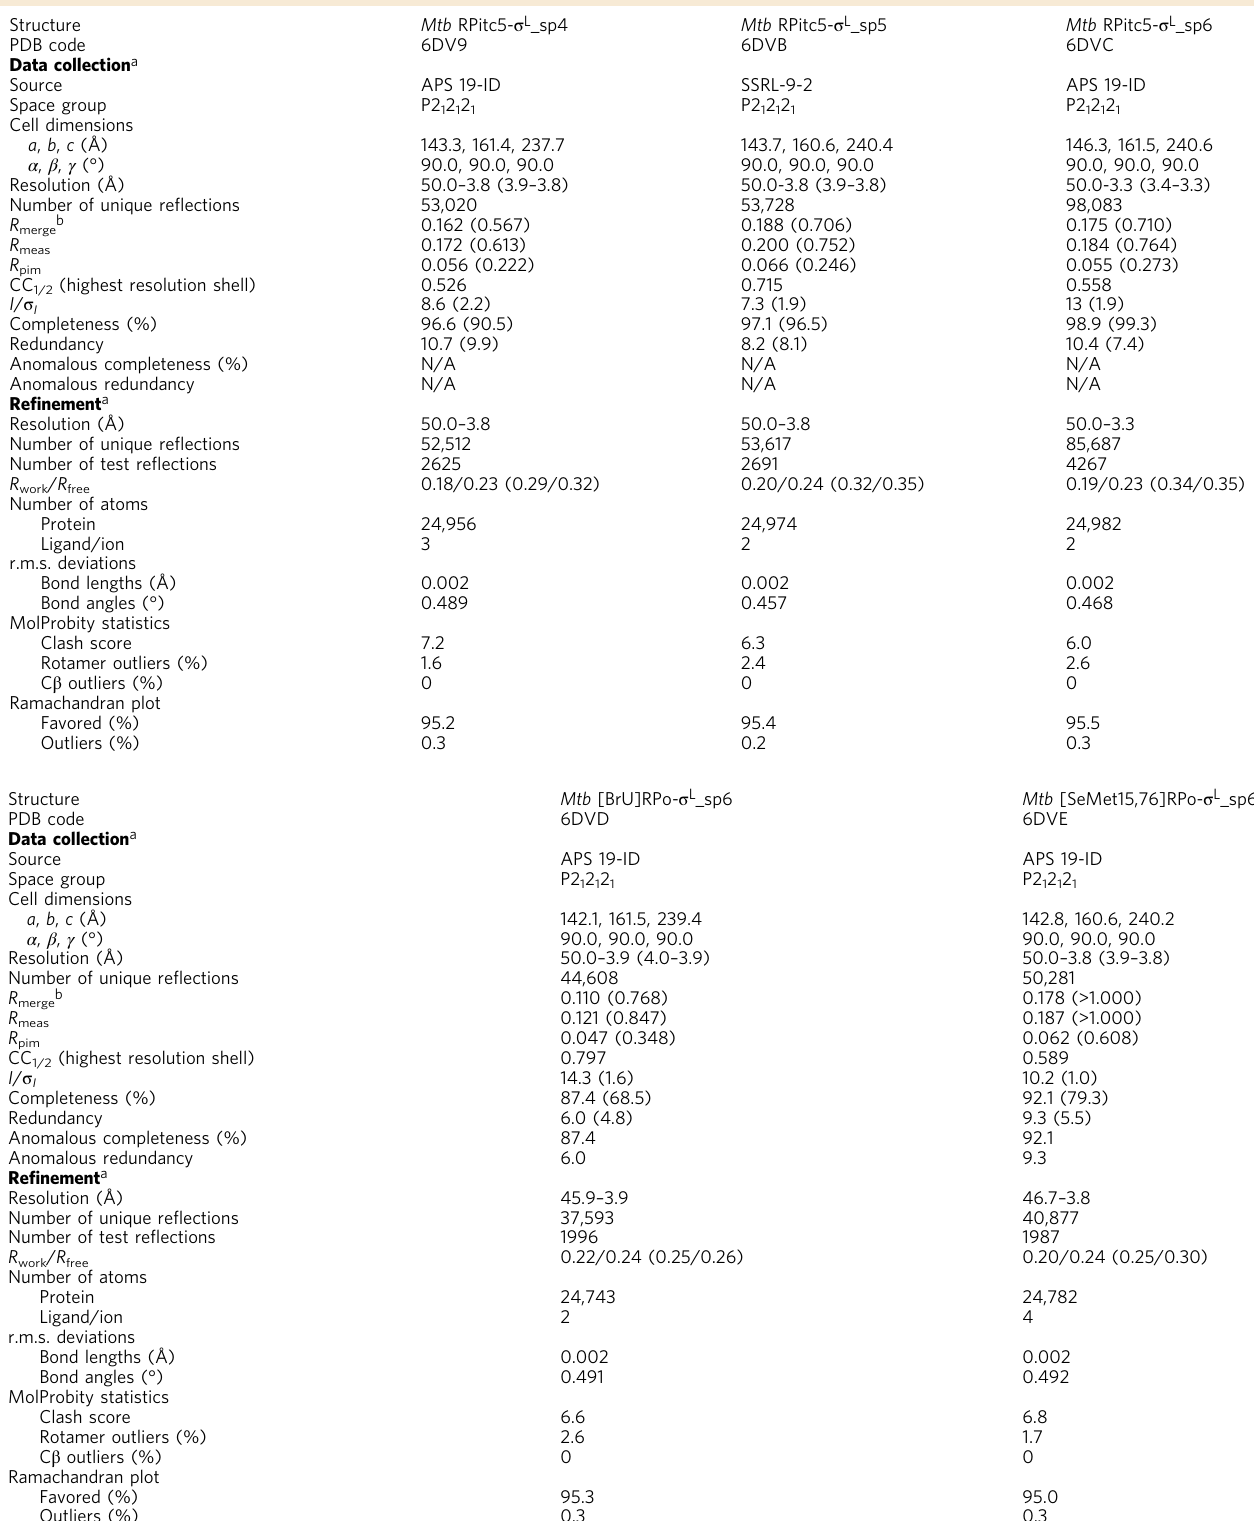
Table 1 Structure data collection and re fi nement